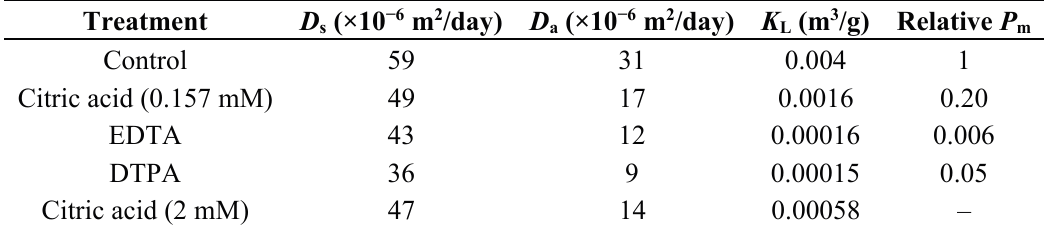
Table 2. Initial estimates of model parameters for calibration with solute